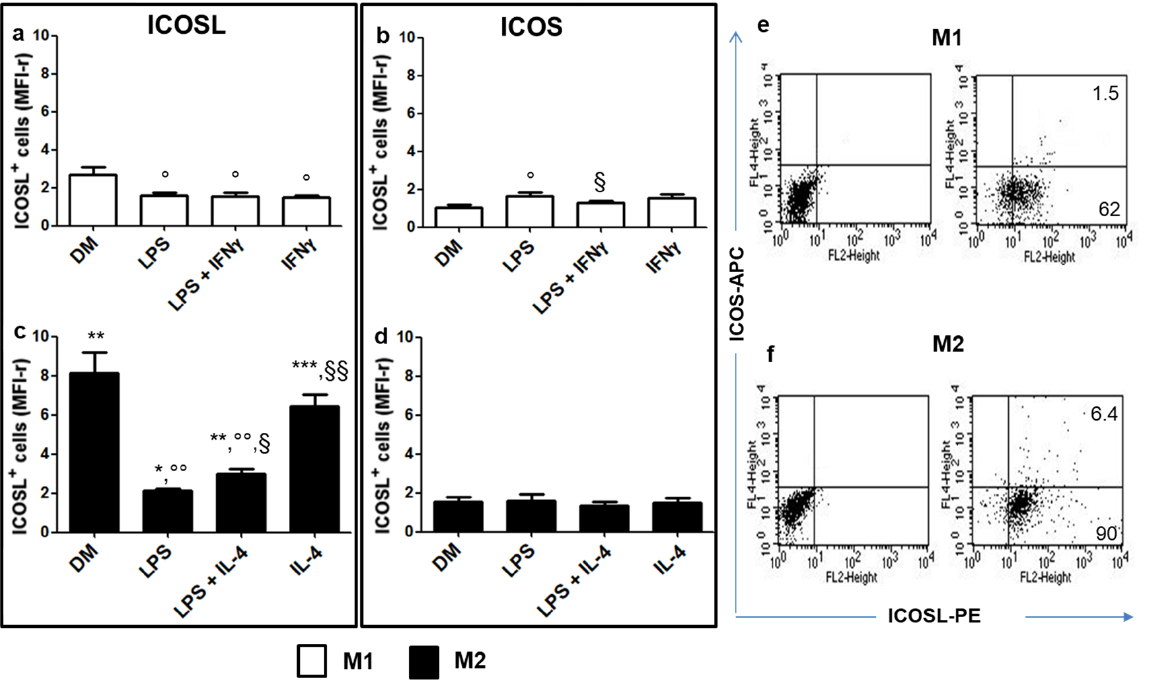
Figure 1. ICOSL and ICOS expression on M1 and M2 cells. Monocytes were cultured in a differentiation medium (DM) (GM-CSF for M1 polarization or M-CSF for M2 polarization). ICOSL ( a – c ) and ICOS ( b – d ) expression was evaluated after 6 days ( d ) (T6) of culture in the presence of GM-CSF or M-CSF alone or after an additional 48 h (T6 + 2) in the presence of LPS, IFN γ or LPS + IFN γ or LPS, IL-4, or LPS + IL-4 (M2) by flow cytometry. Data represent the mean and SEM expressed as mean fluorescence intensity ratio (MFI-R) of results from five independent experiments. Representative cytofluorimetric plots of ICOS and ICOSL expression in DM-treated cells are shown in panels ( e ) (M1 cells) and ( f ) (M2 cells); left panels: negative controls, right panels: positive staining. MFI-R was calculated considering all viable cells according to the following formula: MFI of the stained sample histogram (arbitrary units)/MFI of the control histogram (arbitrary units). * p < 0.05, ** p < 0.01, *** p < 0.0001 versus the corresponding M1; § p < 0.05, §§ p < 0.01 vs LPS or ° p < 0.05, °° p < 0.01 vs. DM.